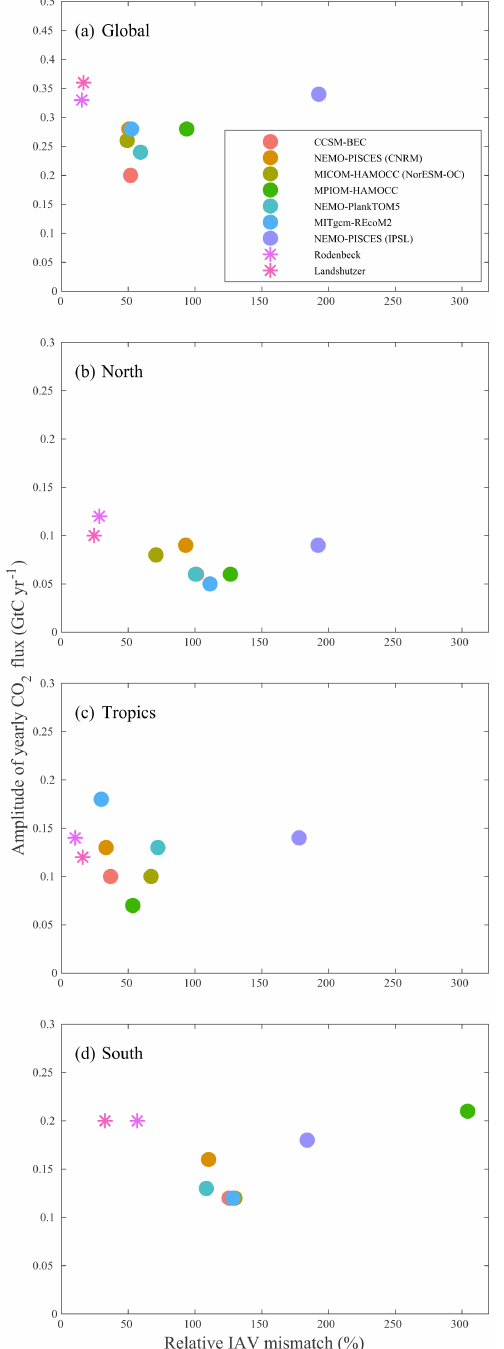
Figure B1. Evaluation of the GOBMs and flux products using the interannual mismatch metric for the period from 1985 to 2017, as proposed by Rödenbeck et al. (2015) and the SOCAT v6 database, versus the amplitude of the annual variability (taken as the annual standard deviation). Results are presented for the globe, north ( > 30 ◦ N), tropics (30 ◦ S–30 ◦ N), and south ( < 30 ◦ S) for the GOBMs (circles) and for the p CO 2 -based flux products (star symbols). The two p CO 2 -based flux products use the SOCAT database and therefore are not fully independent from the data (see Sect.